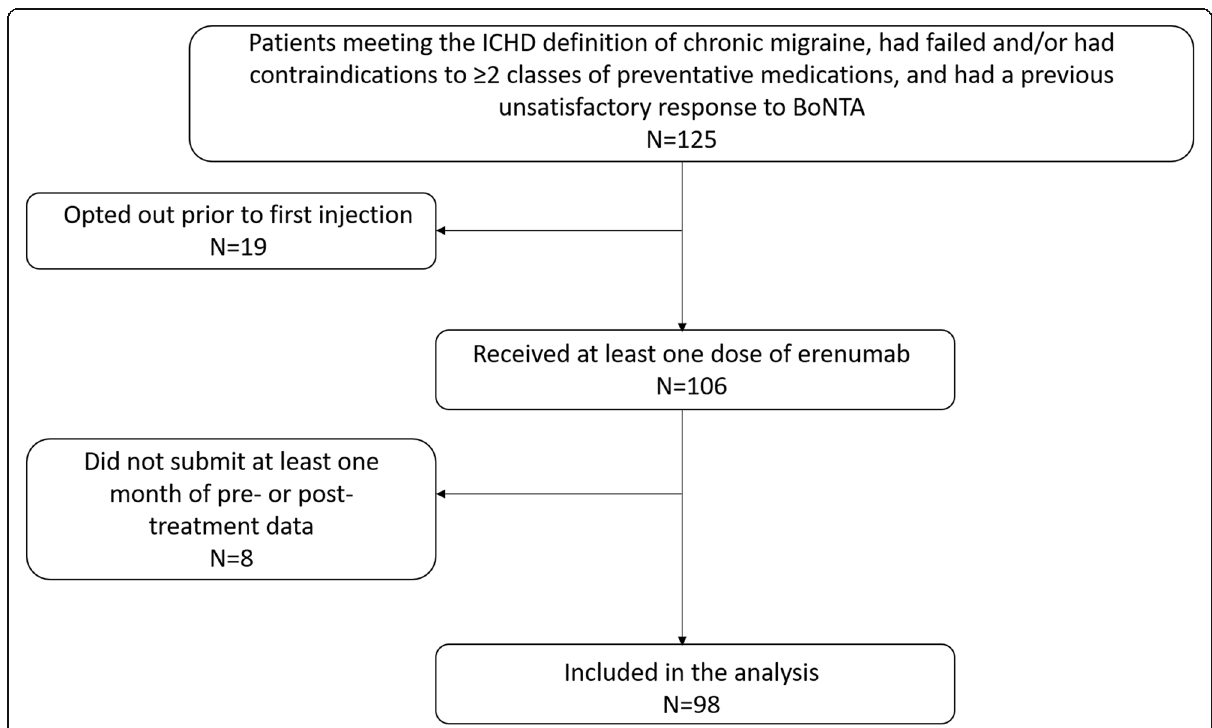
Fig. 1 Audit design flowchart. 125 patients who met the ICHD definition of chronic migraine, had failed and/or had contraindications to ≥ 2 classes of preventative medications, and had a previous unsatisfactory response to BoNTA were selected for the audit. 19 patients did not attend the training day or opted out of the audit prior to the first injection. A total of 106 patients received at least one dose of erenumab. 8 patients who did not submit at least one month of pre- or post-treatment data were excluded from the